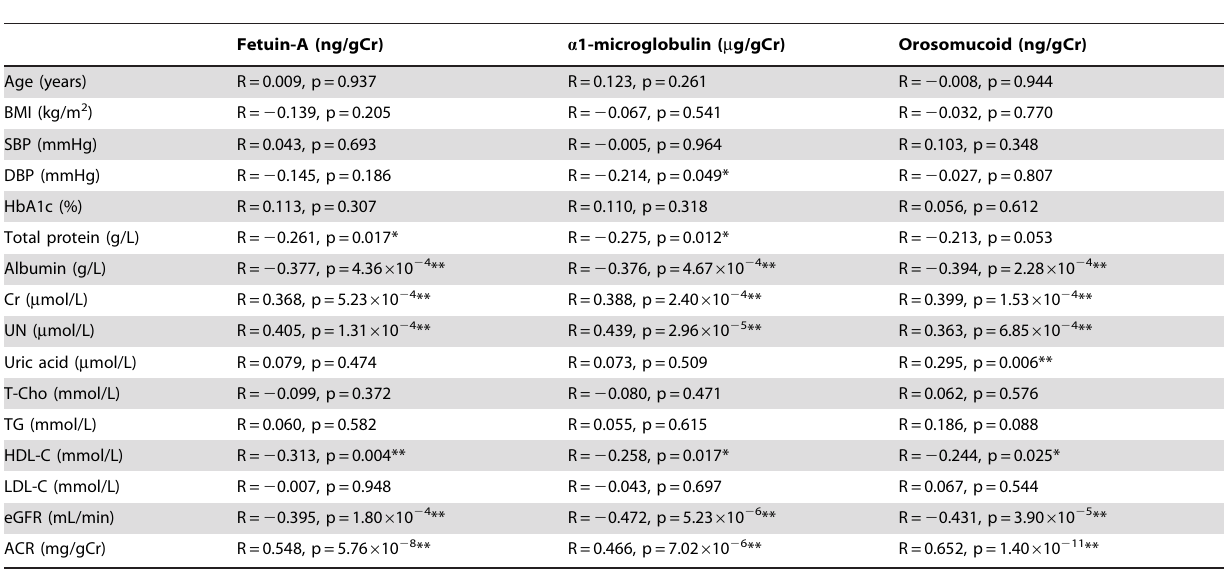
Table 6. Simple correlation of urinary sialylated glycoprotein excretions with various clinical parameters in the patients with type 2 diabetes (n =85).